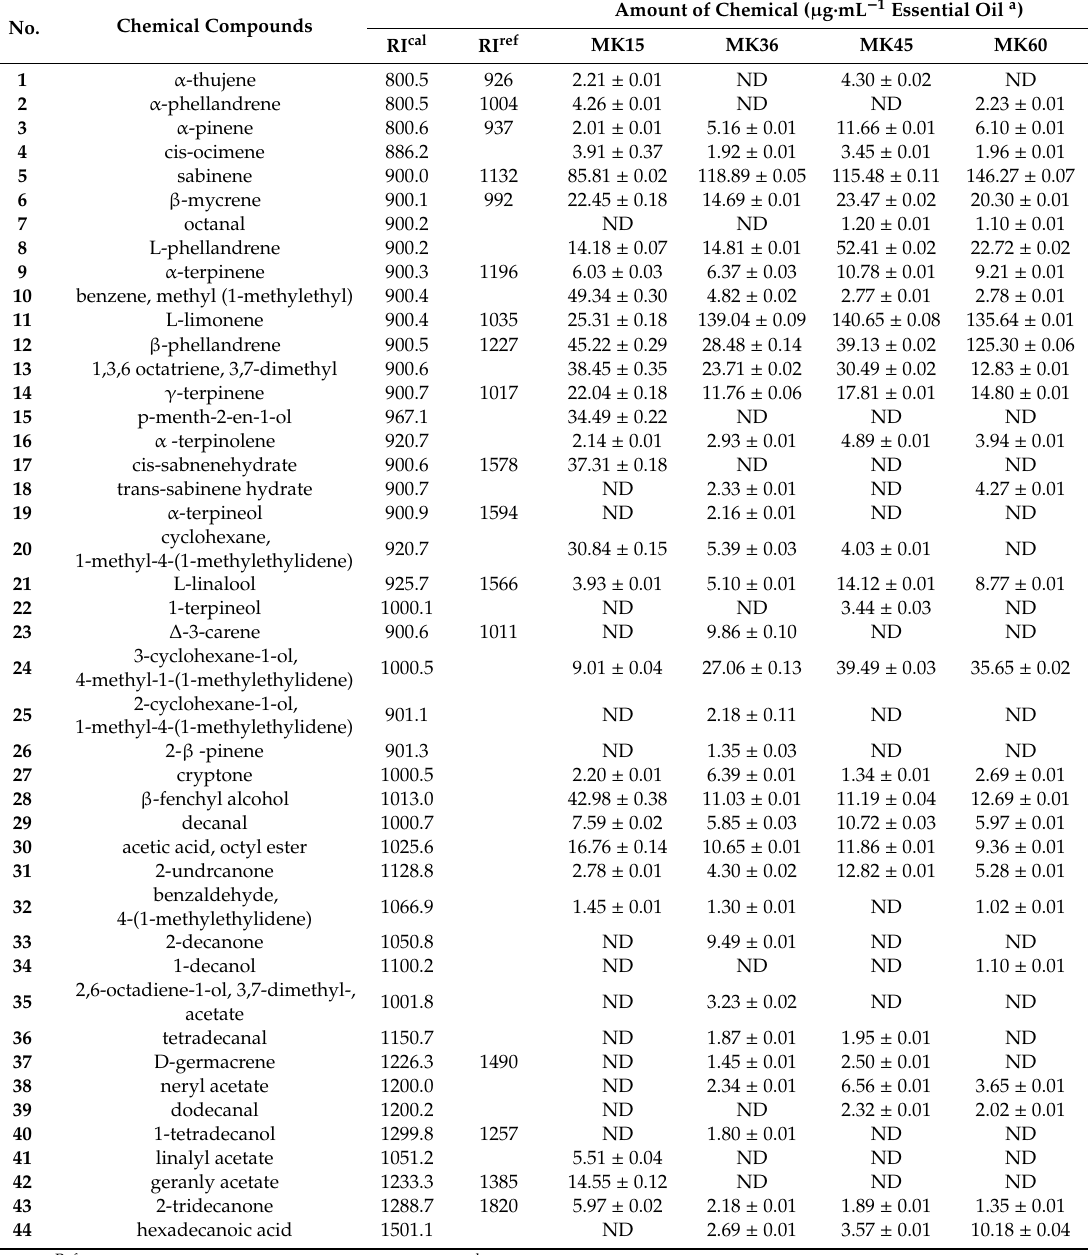
Table 3. Chemical profiles of makhwaen fruit essential